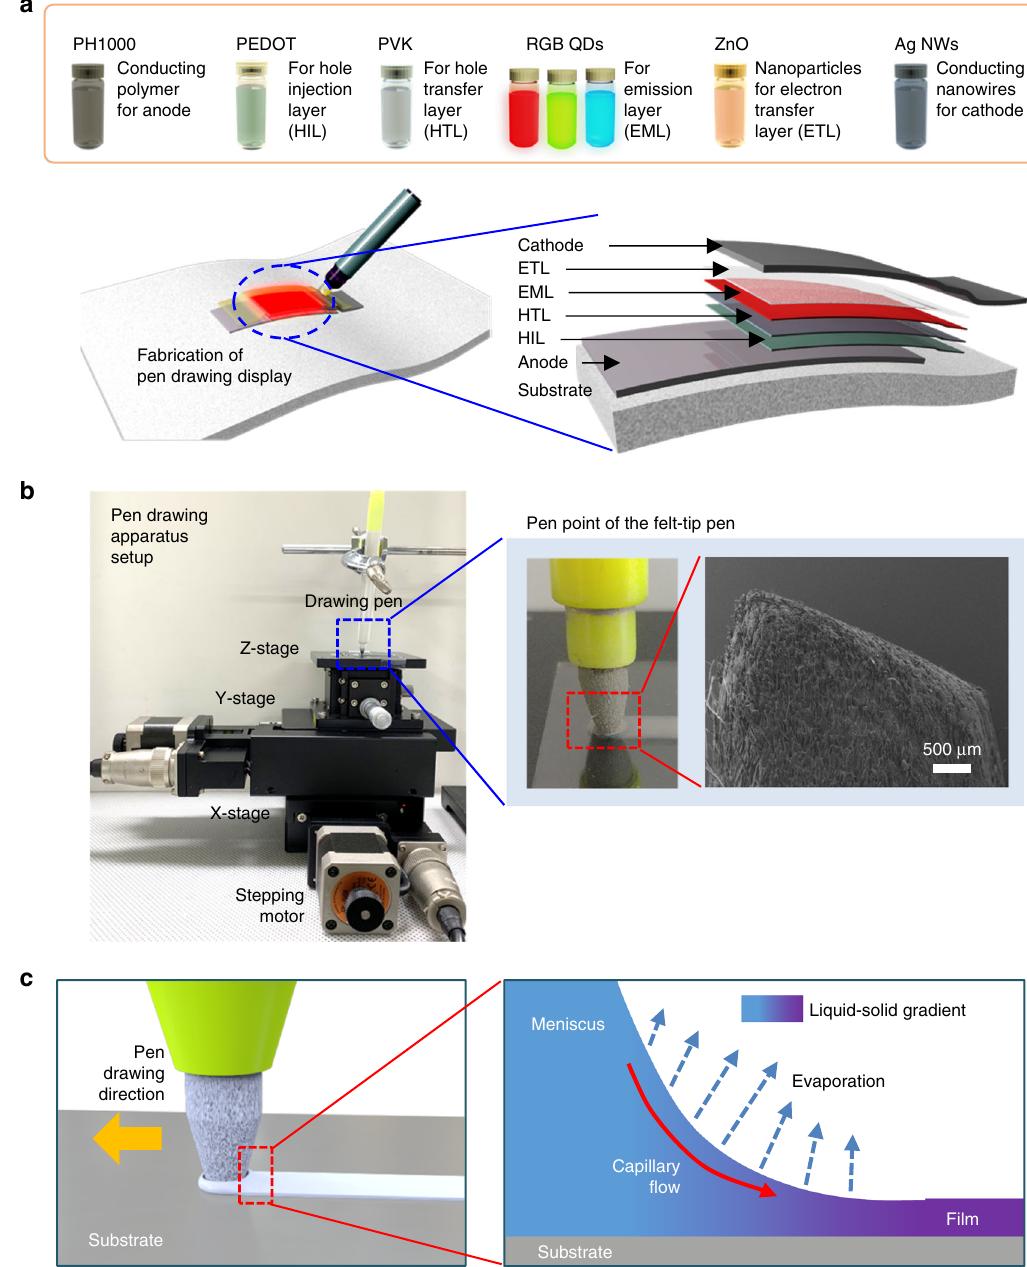
Fig. 1 Pen-drawing display. a Schematic diagram of pen-drawing display with six drawing pens containing anode, hole injection layer (HIL), hole transfer layer (HTL), emission layer (EML), electron transfer layer (ETL), and cathode solutions. A quantum dot light-emitting diode (QD-LED) display fabricated using the pen-drawing method consists of PH1000 (anode), PEDOT:PSS (HIL), PVK (HTL), CdSeS@ZnS (red (R), EML), CdZnSeS@ZnS (green (G), EML), apparatus setup. The pen drawing was performed using a custom-built three-axis micropositioning system controlled by a computer-programmable